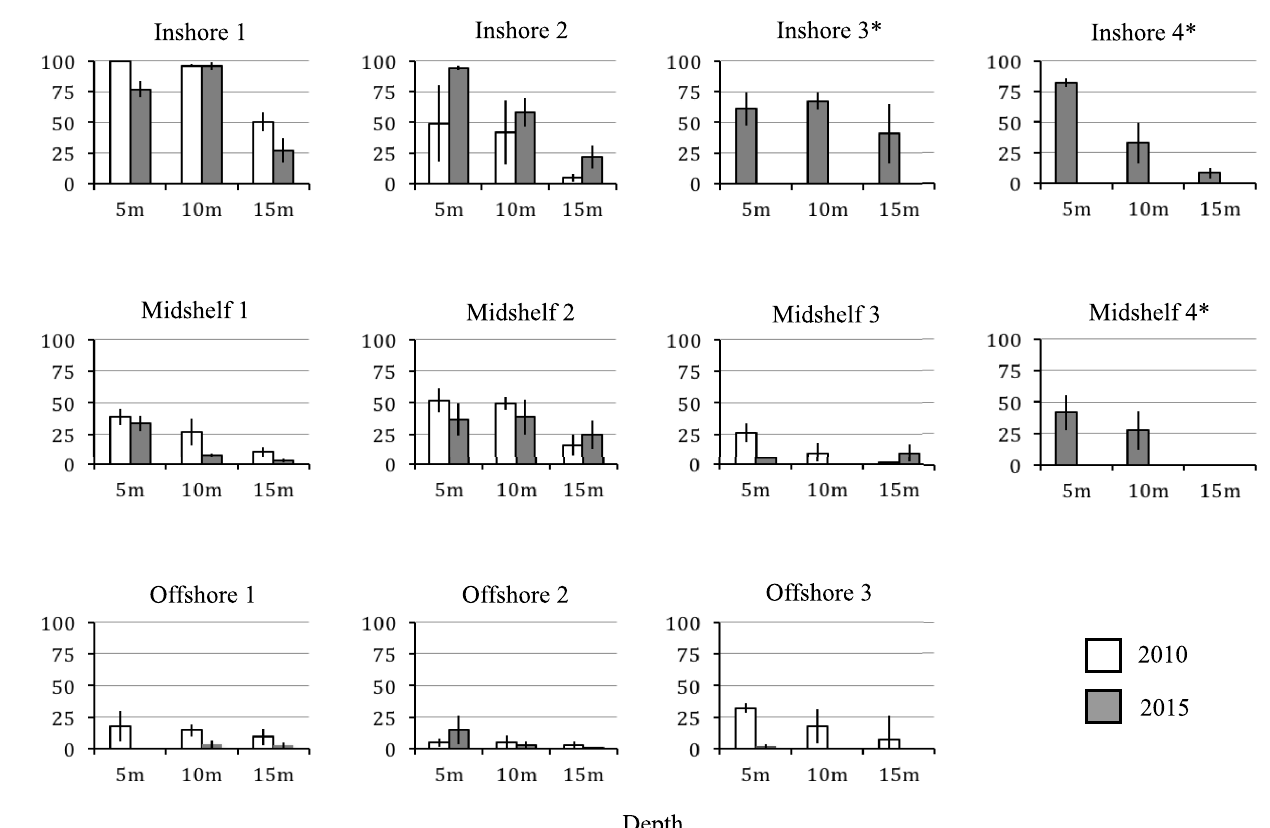
Fig 3. Percentages of bleached scleractinian corals in 2015 (gray bars) at 11 sites in the central Saudi Arabian Red Sea and at each of three depths compared to measurements in 2010 (white bars, from [21]). The bars represent average percent bleaching ( ± SE) measured on 3 replicate 10 m line-intercept transects. Sites Inshore 3, Inshore 4, and Midshelf 4 were not surveyed in 2010, denoted by an (cid:3) .